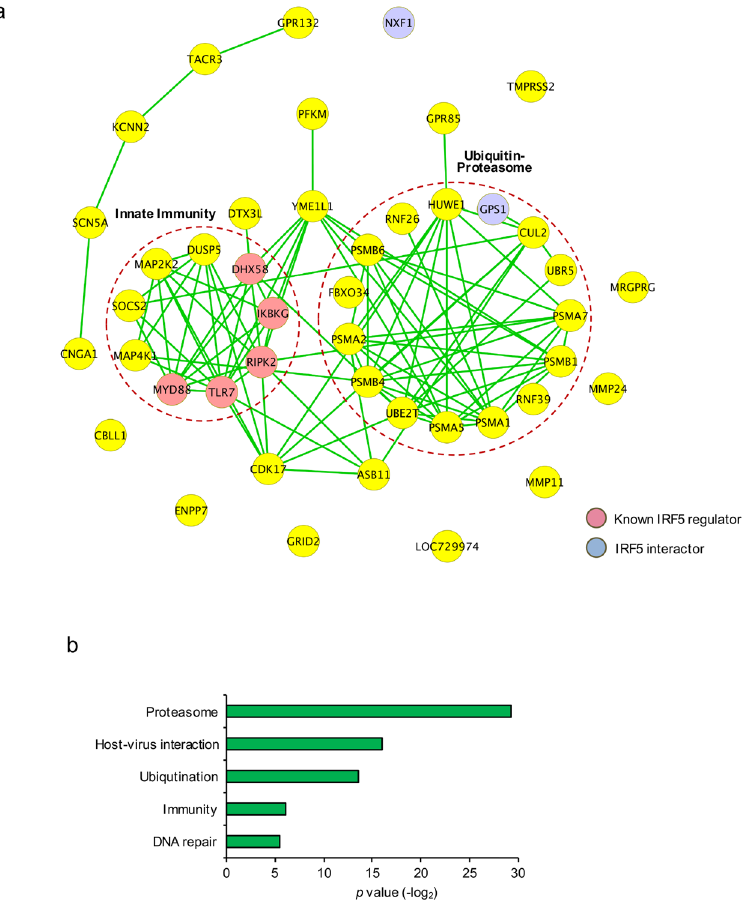
Figure 6. Functional analysis of IRF5 pathway. ( a ) STRING analysis of the validated RNAi hits. Medium confidence (0.4) of STRING was adopted. Pathways of innate immunity and proteasome are indicated by red dashed circle. ( b ) Negative log 2 ( p values) of enriched terms according to the GO of the cellular